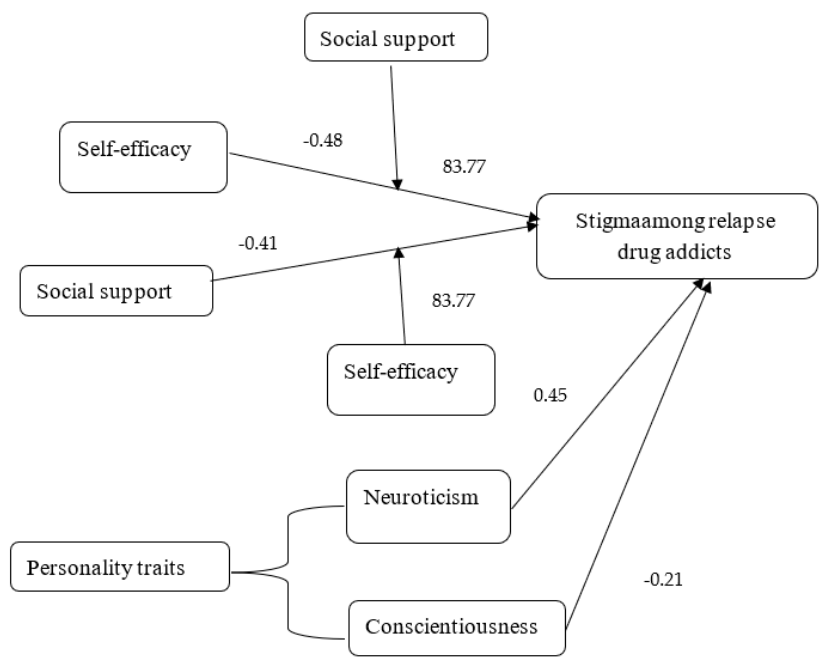
Figure 2. Mod Graph Showing the Interaction Effect of Self-Efficacy and Social Support.